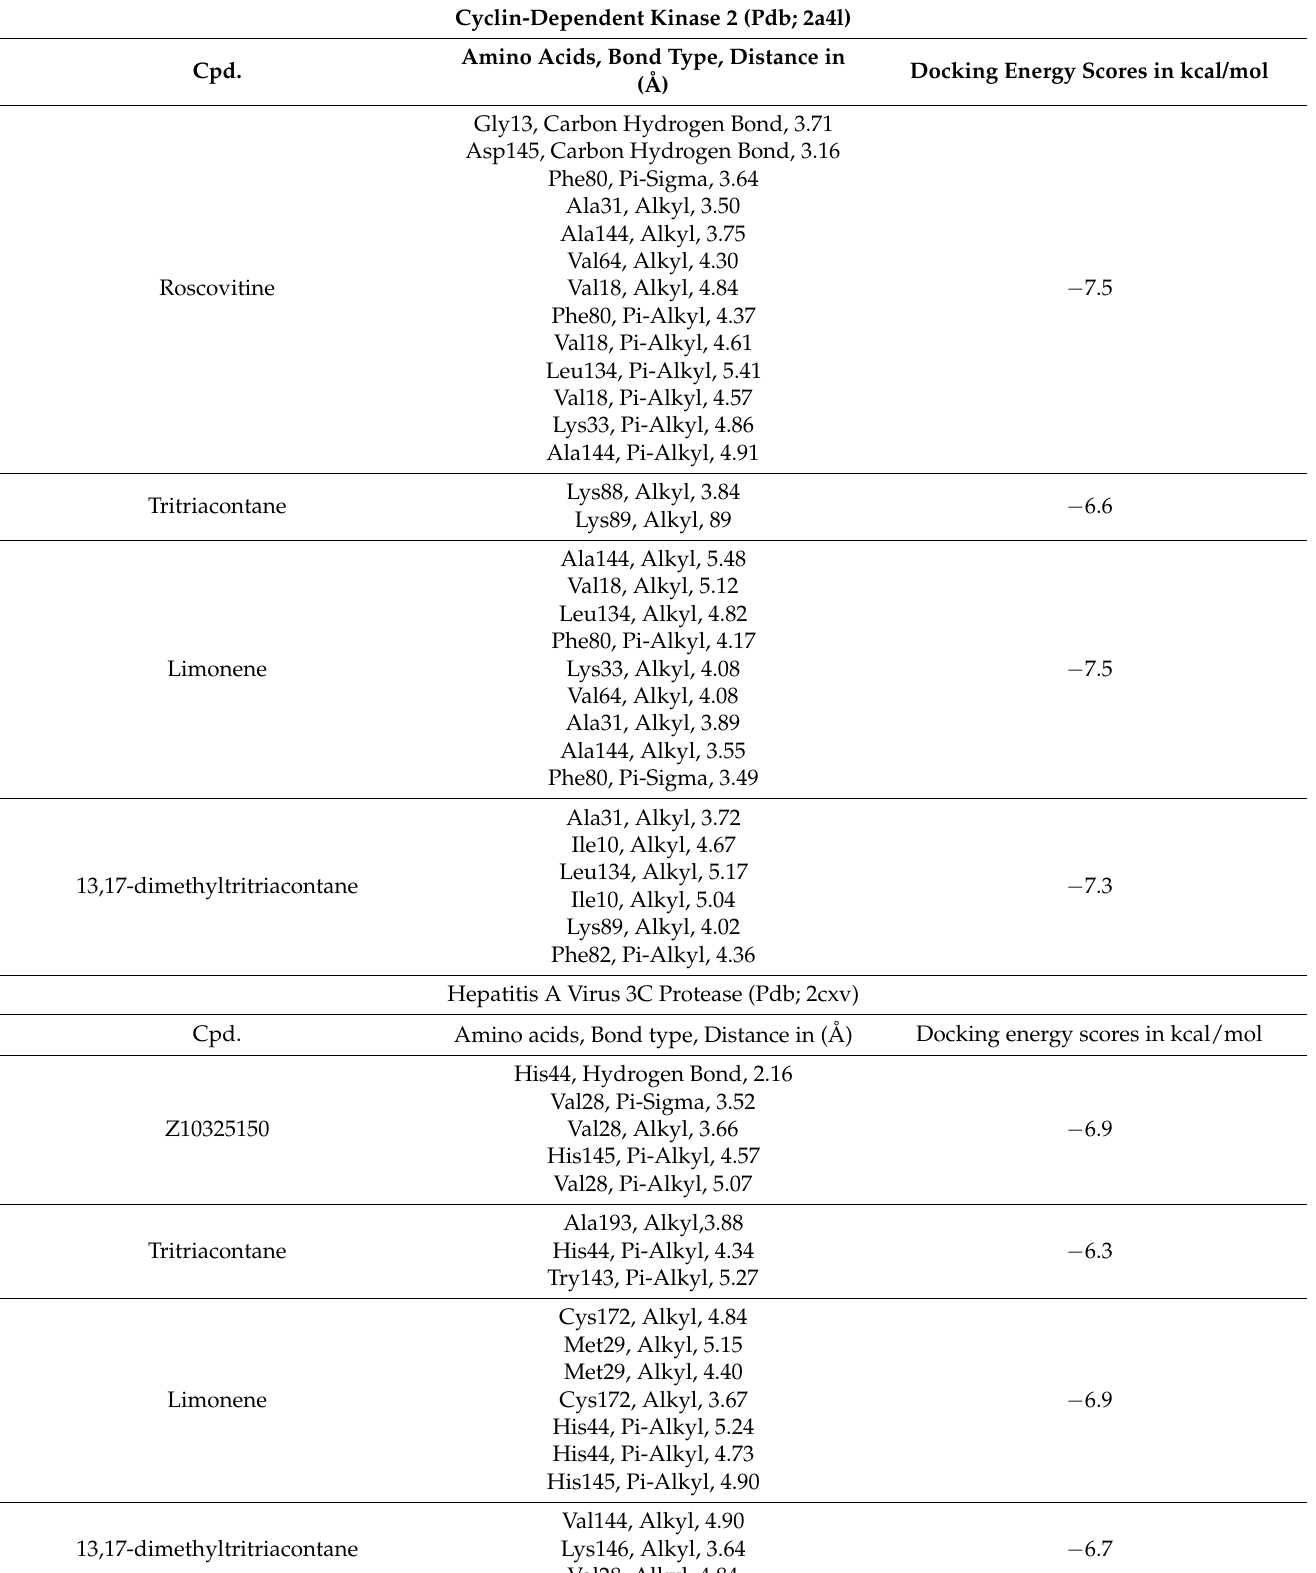
Table 7. Types of interactions of tritriacontane, limonene, and 13,17-dimethyltritriacontane within CKD-2 and HAV 3C protease active site.